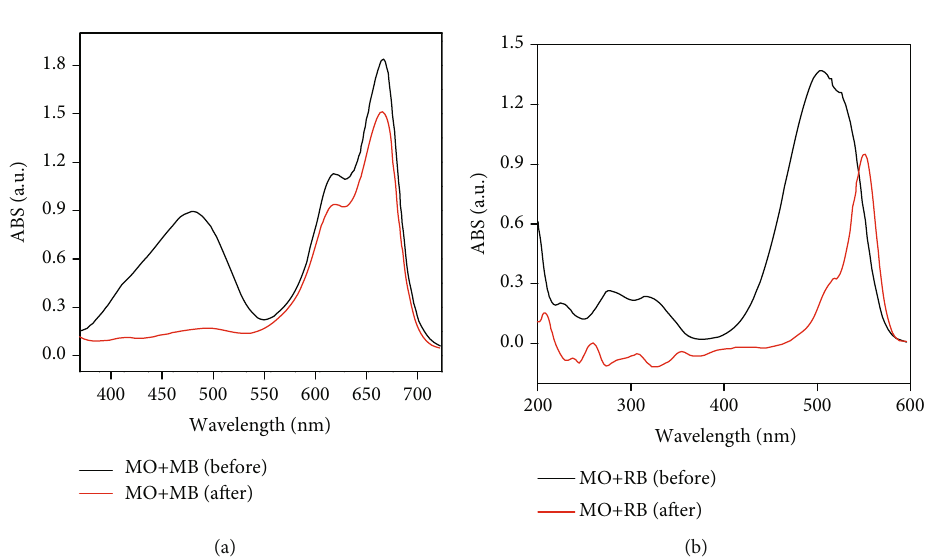
Figure 6: Uv-vis absorption spectra of MO/MB (a) and MO/RB (b) before and after selective adsorption on the surface of MOF/NH